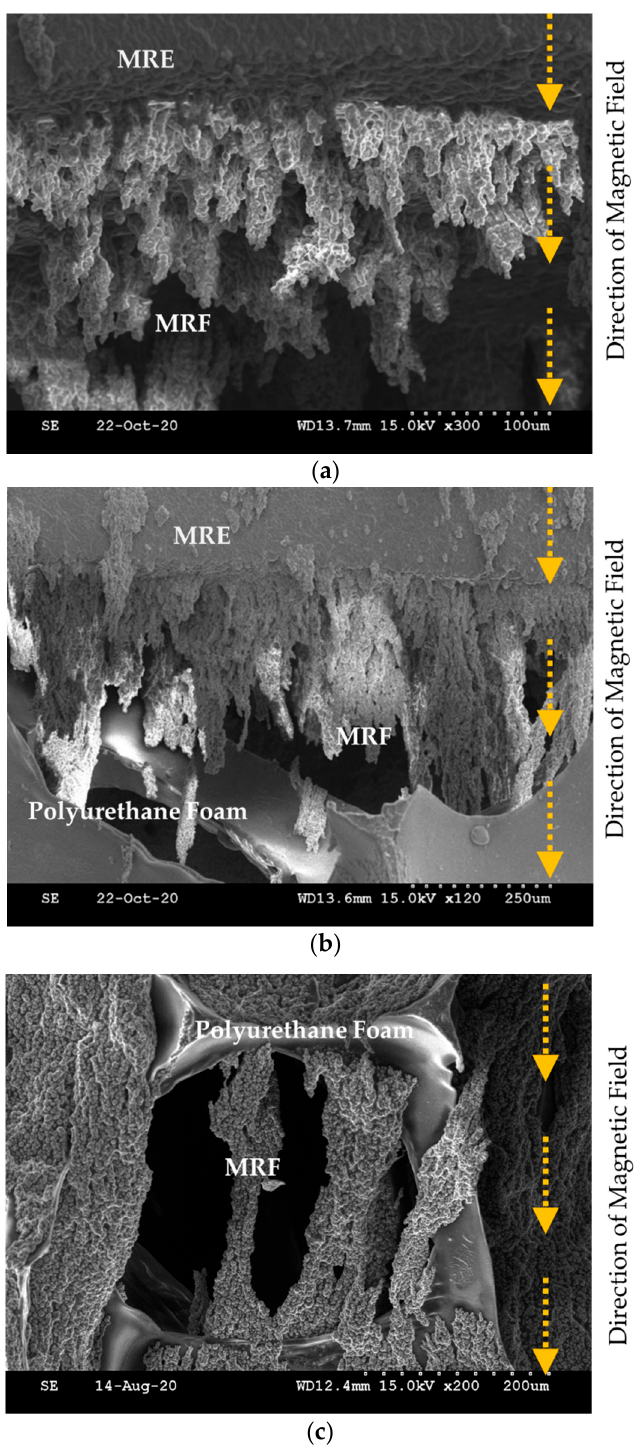
Figure 7. SEM photos of the particle distribution of MR materials under the magnetic field: ( a ) MRE + MRF, ( b ) MRE + MRF + polyurethane foam, ( c ) MRF + polyurethane foam.